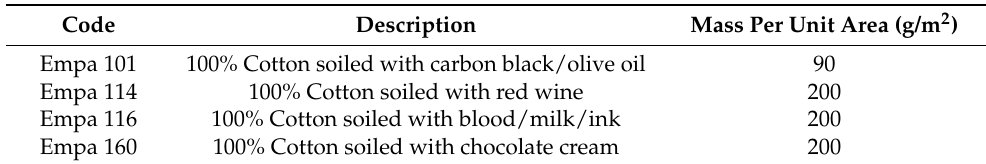
Table 1. Code and properties of used Empa standard soiled fabrics .